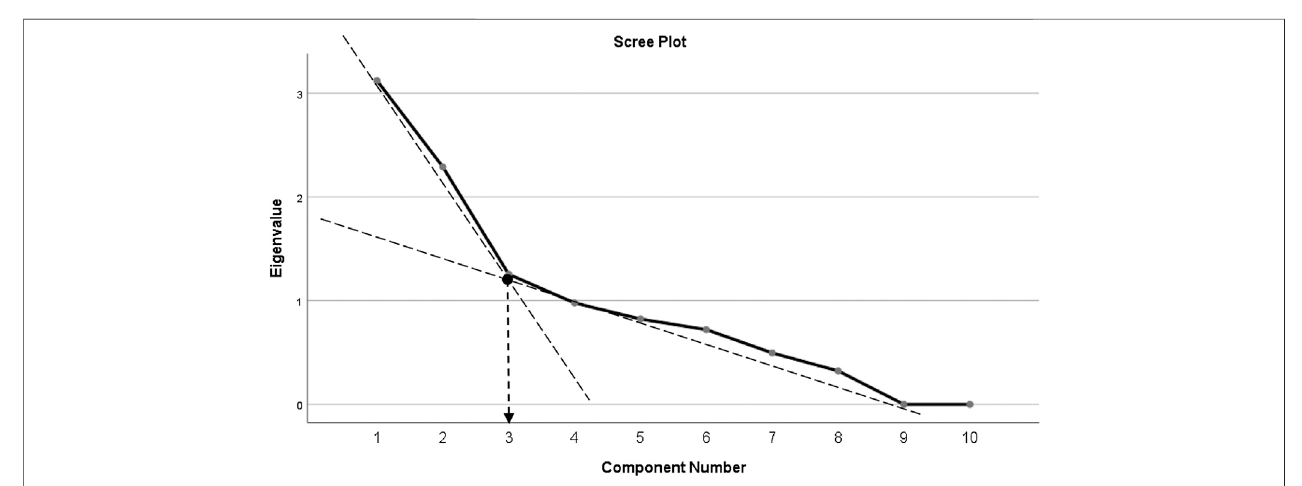
FIGURE 1 | Scree plot of factor analysis of